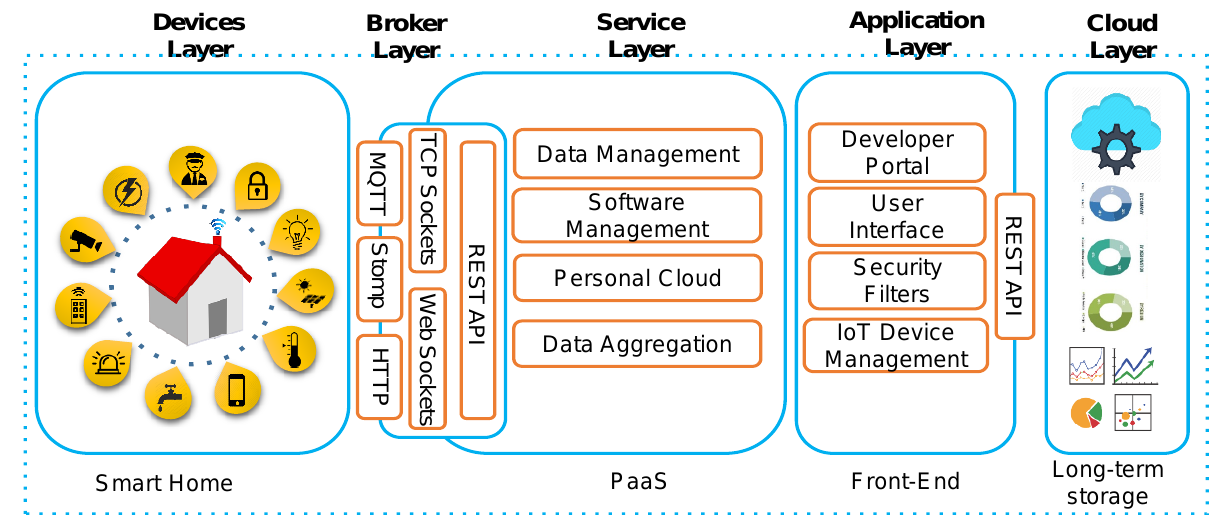
Figure 2. The proposed framework consists of five layers such as devices, broker, service, application, and cloud layers.